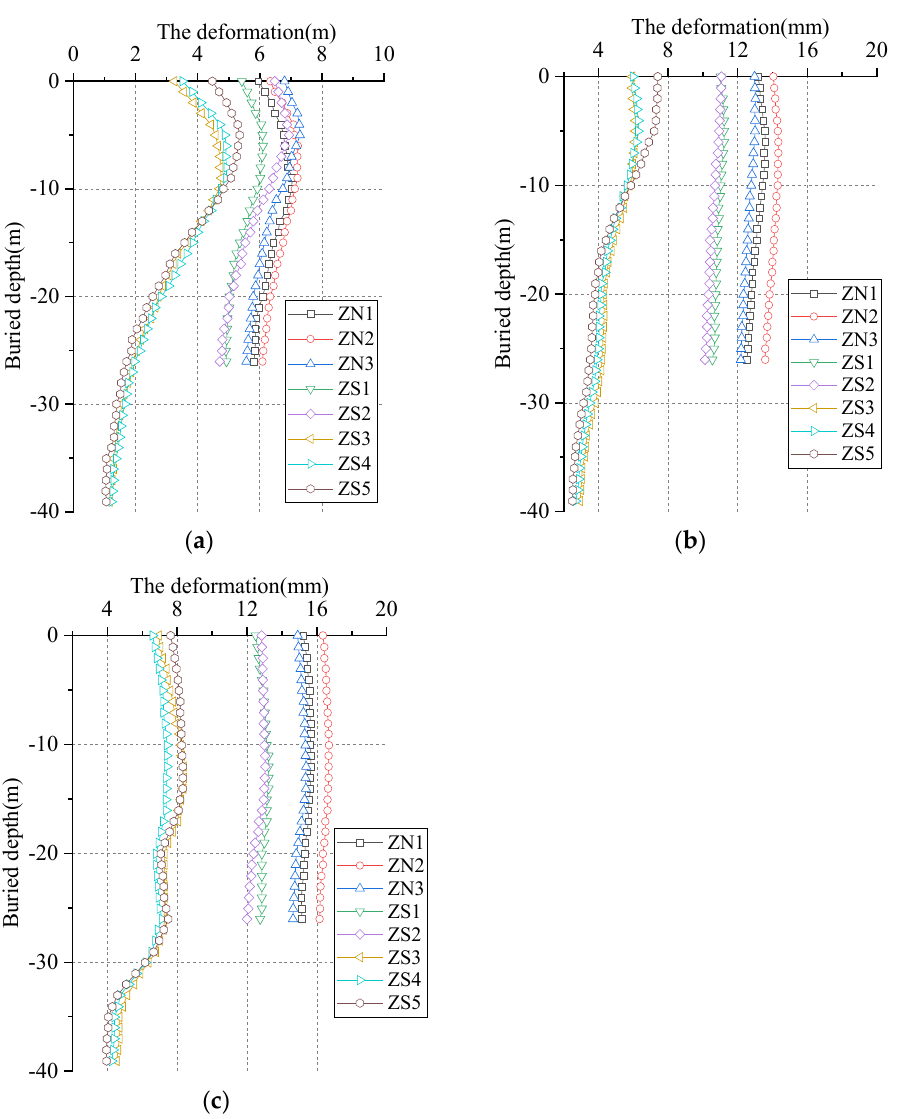
( b ) Figure 18. Deformation of retaining structure in pit-in-pit district. ( a ) working Condition 4. ( b )